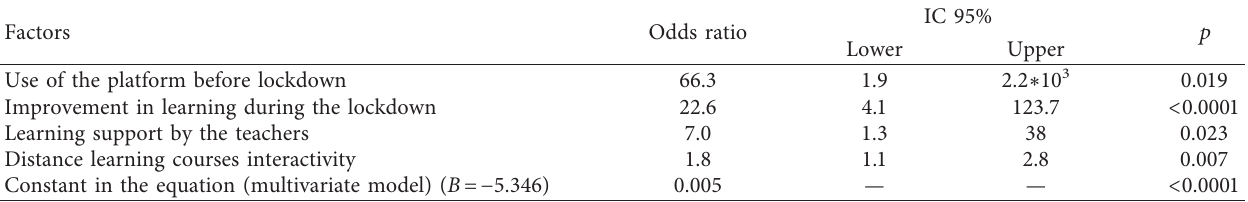
Table 5: Factors associated to the satisfaction of distance learning in the multivariate model analysis by binary logistic regression.